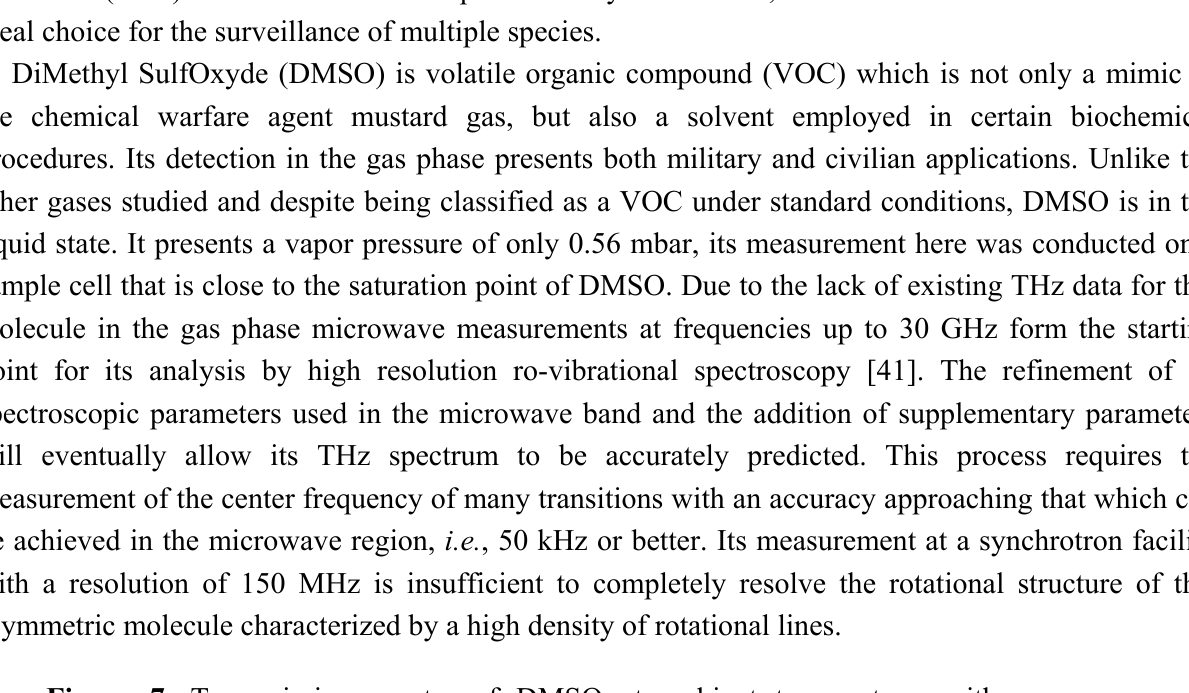
Figure 7. Transmission spectra of DMSO at ambient temperature, with a pressure of 0.1 mbar, for path lengths of 896 cm (red) and 1,344 cm